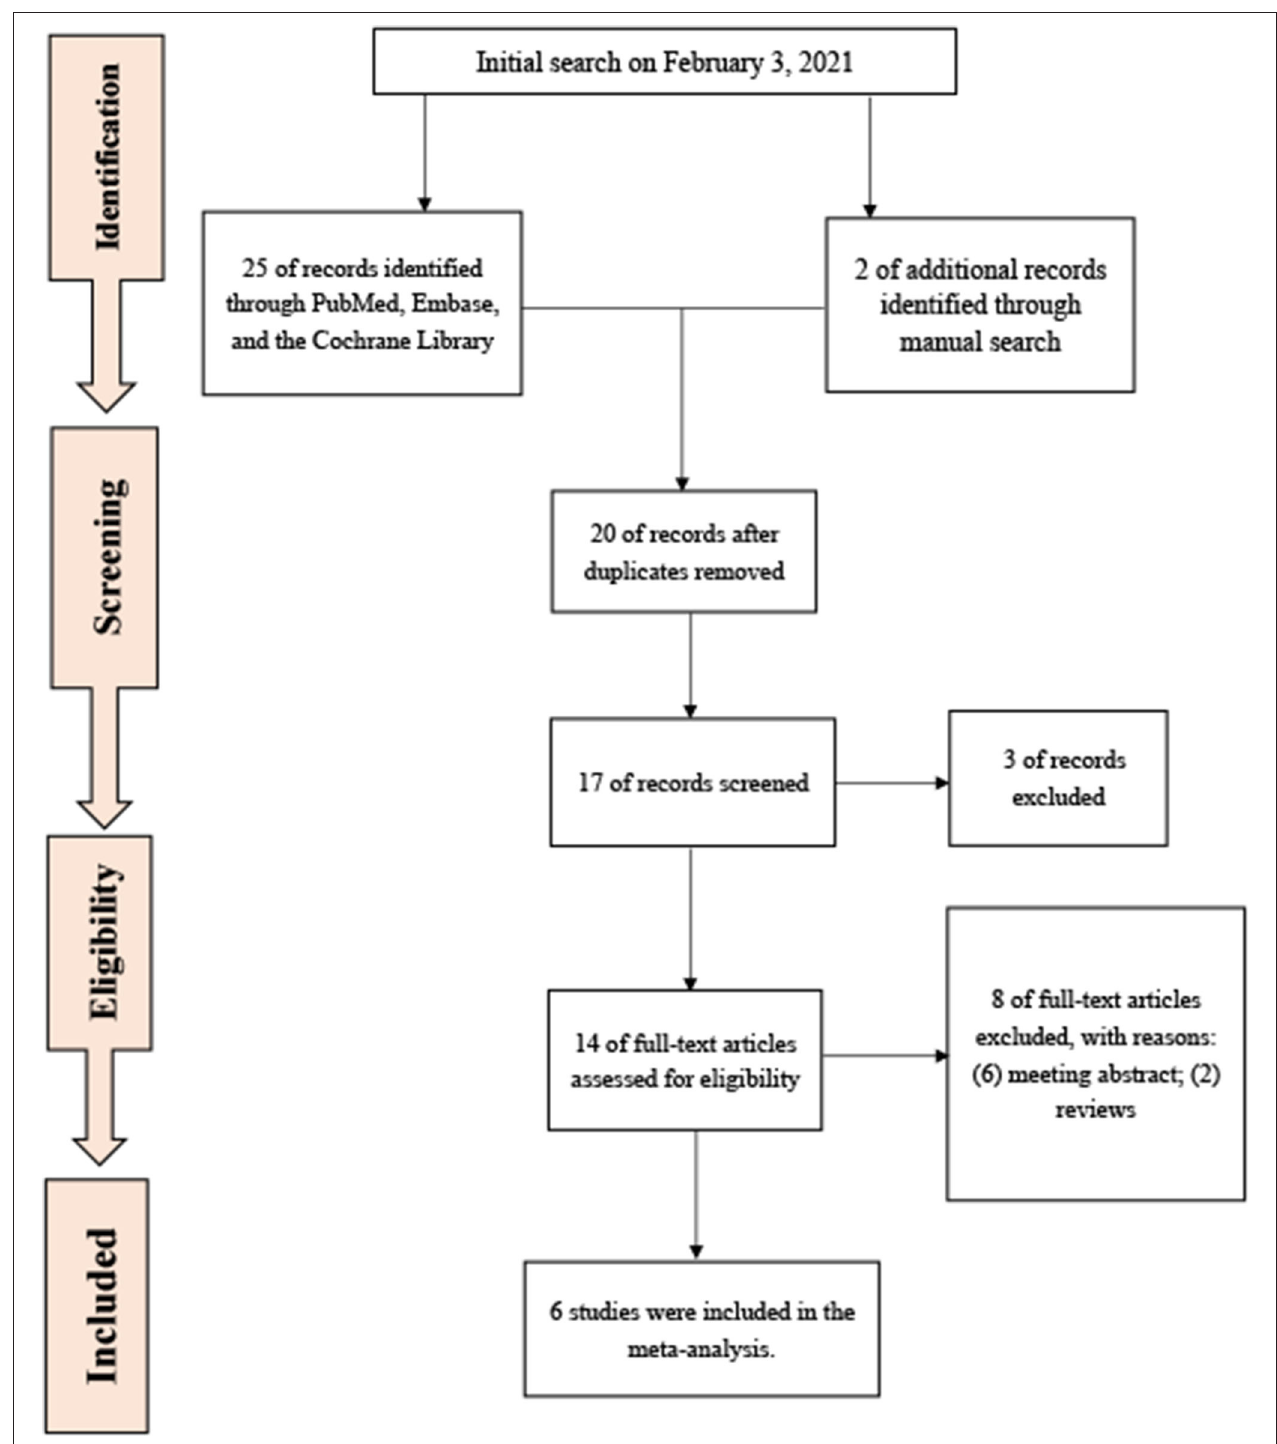
FIGURE 1 | The preferred reporting items for systematic review and meta-analysis (PRISMA)